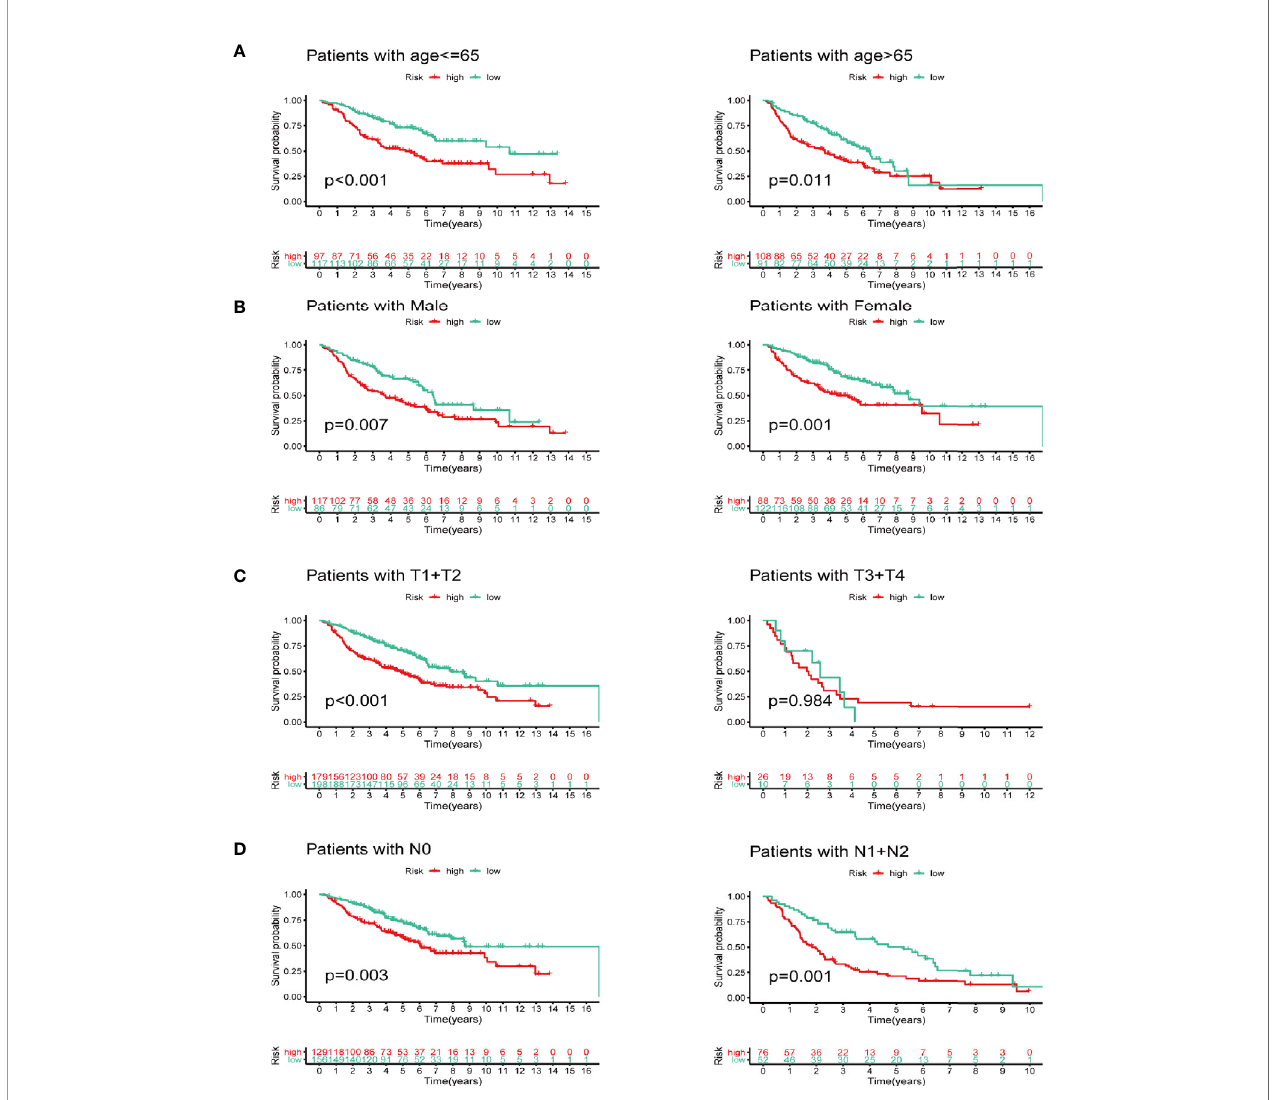
FIGURE 5 | Subgroup survival analysis based on different clinicopathological features of LUAD. (A) Age. (B) Gender. (C) T stage. (D) N